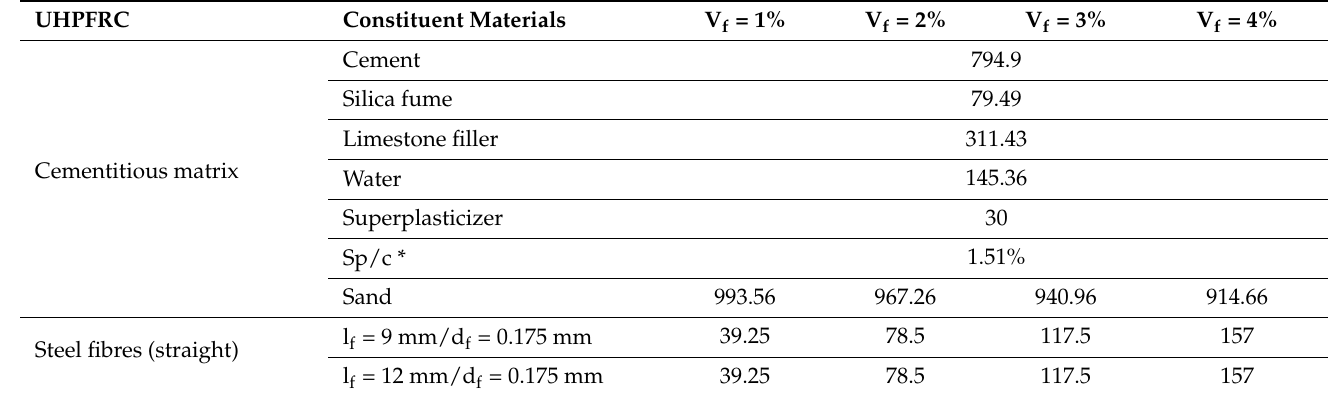
Table 2. Mix-proportions of UHPFRC employed in this study (kg/m 3